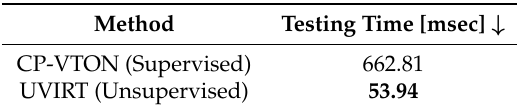
Table 4. Testing time comparison of proposed UVIRT vs. CP-VTON on the test images of the C2C market dataset. We use an NVIDIA Tesla V100 in our